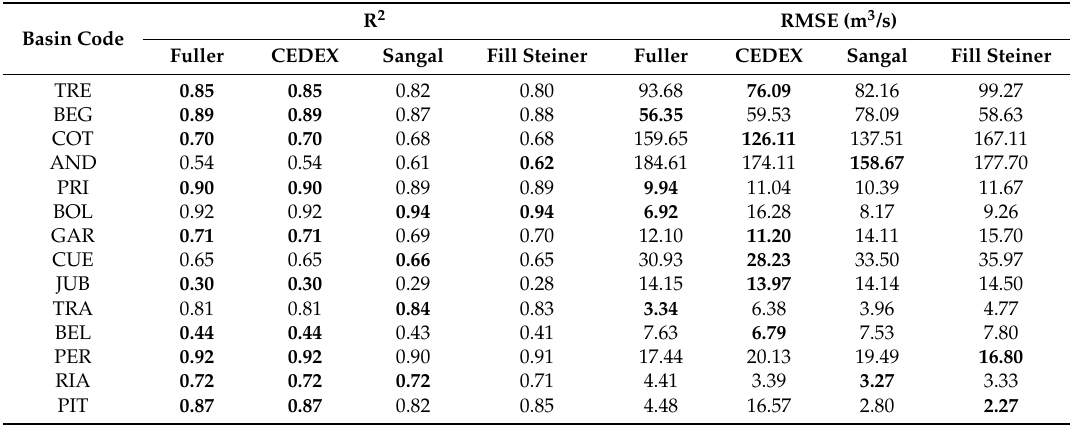
Table 3. Evaluation of the results of empirical formulas based on R 2 and root mean square error (RMSE)